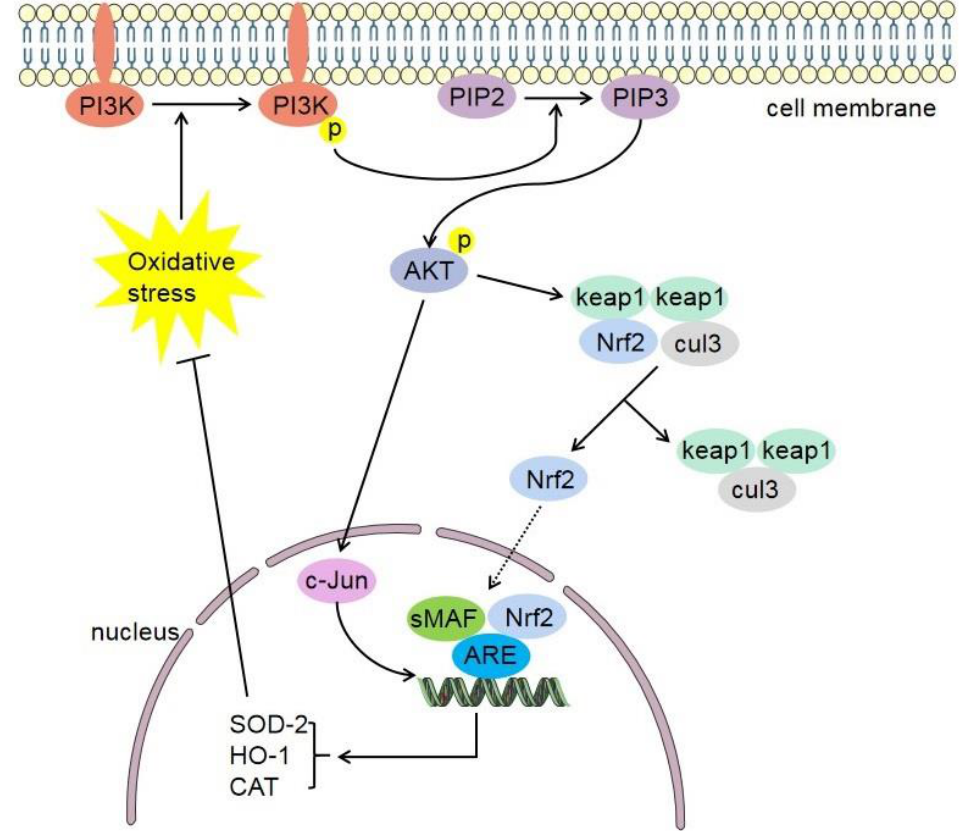
Figure 3. PI3K/Akt-Nrf2 signaling pathway. Under oxidative stress conditions, the phosphorylation expression of PI3K increases. Akt is a downstream target of PI3K. Akt promotes the dissociation